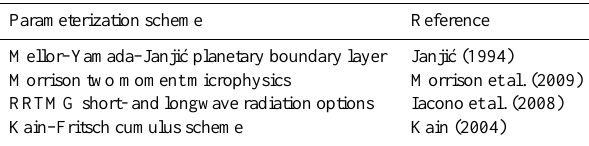
Table 1. Key parameterizations chosen for the model setup.